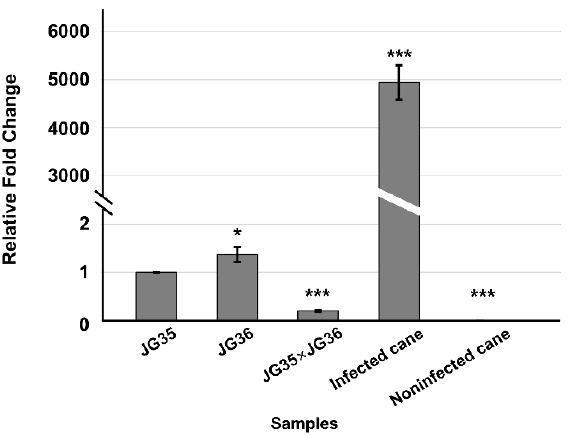
Figure 1. Sspep1 transcript accumulation in vitro and in planta . Haploid basidiospores (JG35 and JG36) and in vitro dikaryotic hyphae (JG35 × JG36) derived from the pairing of opposite S. scitamineum mating types were cultured on YEPS plates for three days before being harvested for total RNA isolation. Fresh whip tissues from S. scitamineum -infected sugarcane plantlets were used for the isolation of total RNA. RT-qPCR was performed using cDNA reverse-transcribed from the total RNA. House-keeping gene actin was used as a reference gene. Transcript levels of Sspep1 in all samples were expressed as the fold change, as compared to that of JG35, using the 2 −ΔΔ Ct method [33]. Means ± S.E. were derived from three independent biological repeats, each of which contained three technical repeats. p -values were calculated based on a Student’s t-test of replicate 2 −ΔΔ Ct values between a sample and JG35. * p < 0.05 and *** p < 0.001 .